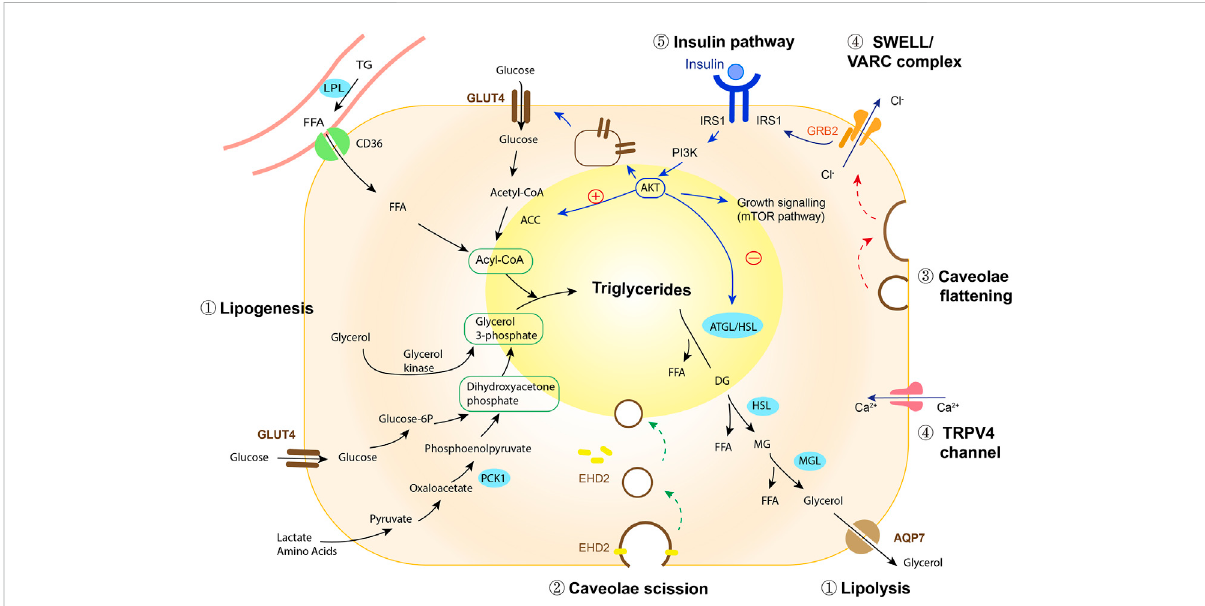
FIGURE 1 Regulation ofadipocyteexpansion. ① Lipid dropletgrowth ismediated via thebalancebetweenlipogenesisandlipolysis (black arrows,andsee Supplementary Box S1). Insulin plays a role in promoting lipogenesis while inhibiting lipolysis, keeping lipid stored in adipocytes. ② EHD2 stabilizes caveolae on the cell membrane and disassembly of EHD2 facilitates caveolae to detach from the cell membrane, transporting the lipid-enriched membrane into the cytosol where it integrates into the lipid droplet (green arrows). ③ In response to mechanical stretch or osmotic pressure (red arrows), caveolae fl atten, increasing cell membrane area. ④ Lipid droplet expansion and caveolae fl attening activate SWELL/VARC ion channel complexes causing calcium ion ef fl ux. TRPV4 ion channels sense changes in intracellular volume induced by lipid droplet enlargement, activating calcium ion in fl ux. The activation of ion channels adjusts osmotic pressure and facilitates the cell to swell. In addition, the fl attening of caveolae triggers a restructuring of the SWELL1/VRAC complex, destabilizing GRB2-IRS1 interactions and activating insulin-mediated growth signaling. ⑤ Insulin regulates lipogenesis and lipolysis (blue arrows), whilst also mediating activation of growth and mitogenic pathways, in order to accommodate the increased protein and transcript demands required for cell growth. Abbreviations: ACC, acetyl-CoA carboxylase; AKT, protein kinaseB;AQP7,aquaglyceroporin-7;ATGL/HSL,adiposetriglyceridelipase/hormone-sensitivelipase;EHD2,EH-domain – containingprotein2;FFA, free fatty acid; glucose-6-p, glucose-6-phosphatase; GLUT4, glucose transporter type 4; GRB2, growth factor receptor bound 2; IRS1, insulin receptor substrate 1; LPL, lipoprotein lipase; MGL, monoacylglycerol lipase; PCK1, phosphoenolpyruvate carboxykinase; PI3K,